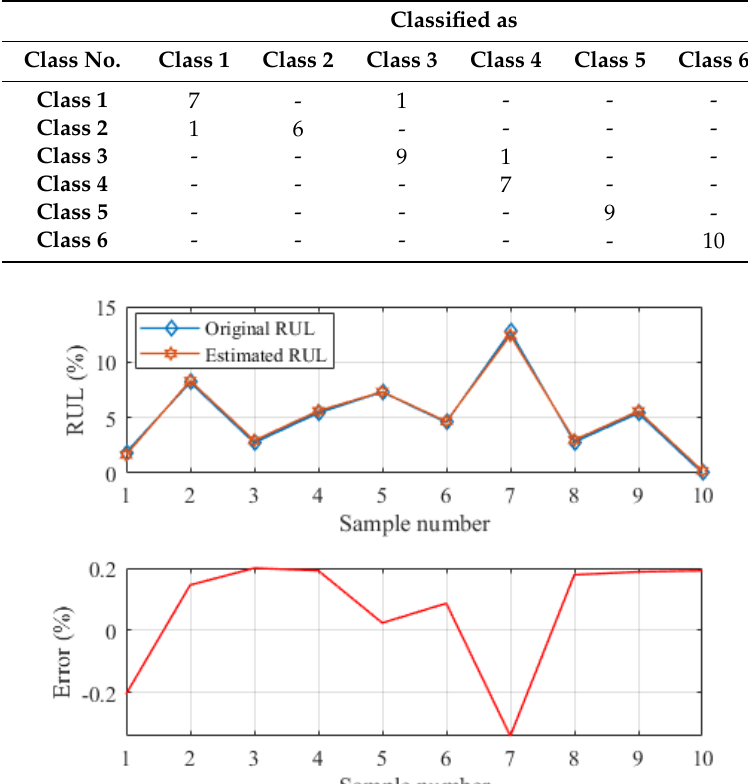
Table 2. Test results of RUL classification model using full discharge data features.